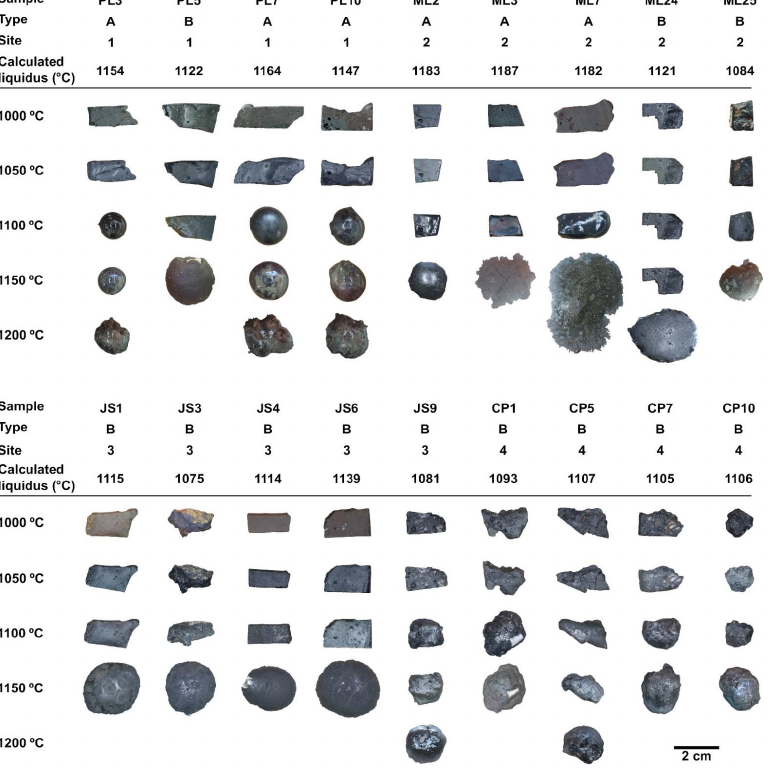
Figure 8. Appearance of selected samples exposed to various temperature conditions.